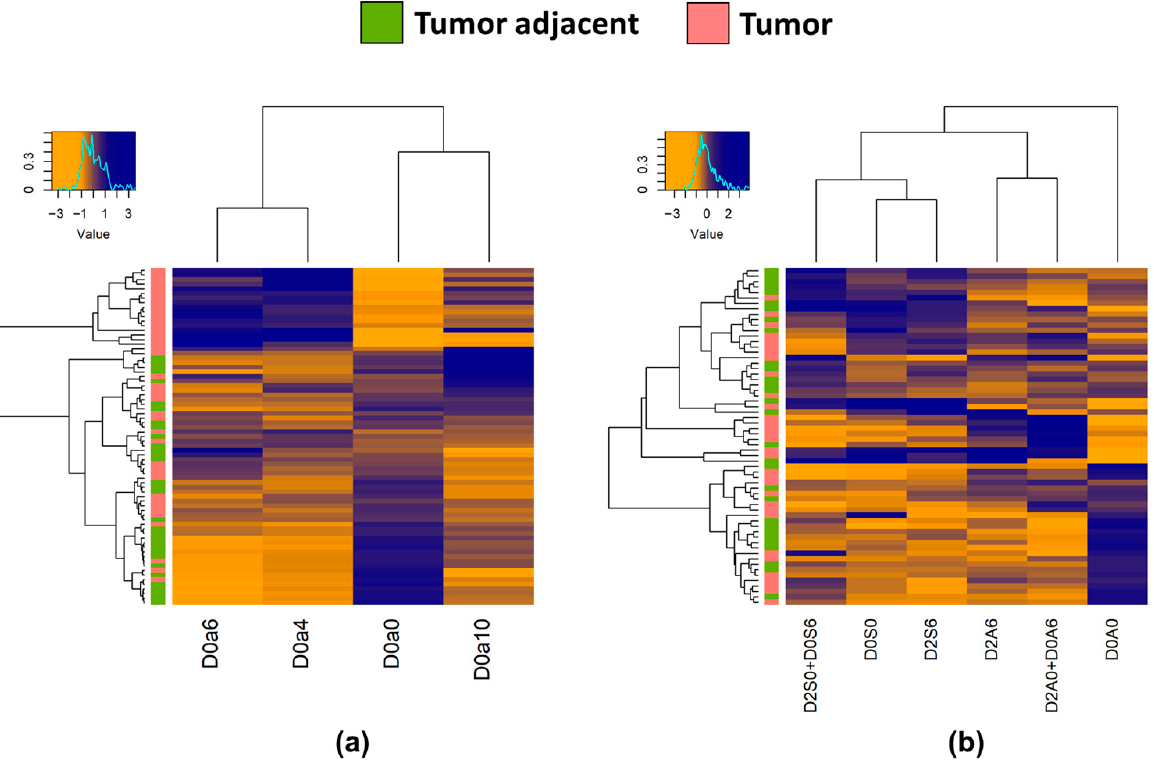
Figure 4. Heatmaps with hierarchical clustering of the ( a ): CS and ( b ): HS disaccharides between all adjacent and all tumor samples. The top left corner histogram shows correspondence between color hues and values.